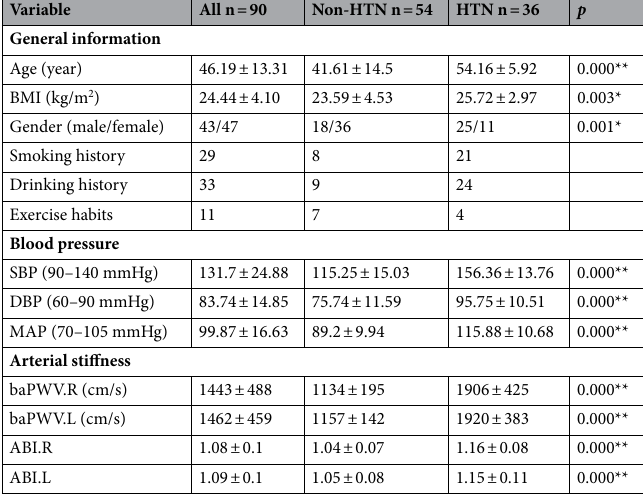
Table 1. Descriptive statistical analysis among general information, blood pressure, and arterial